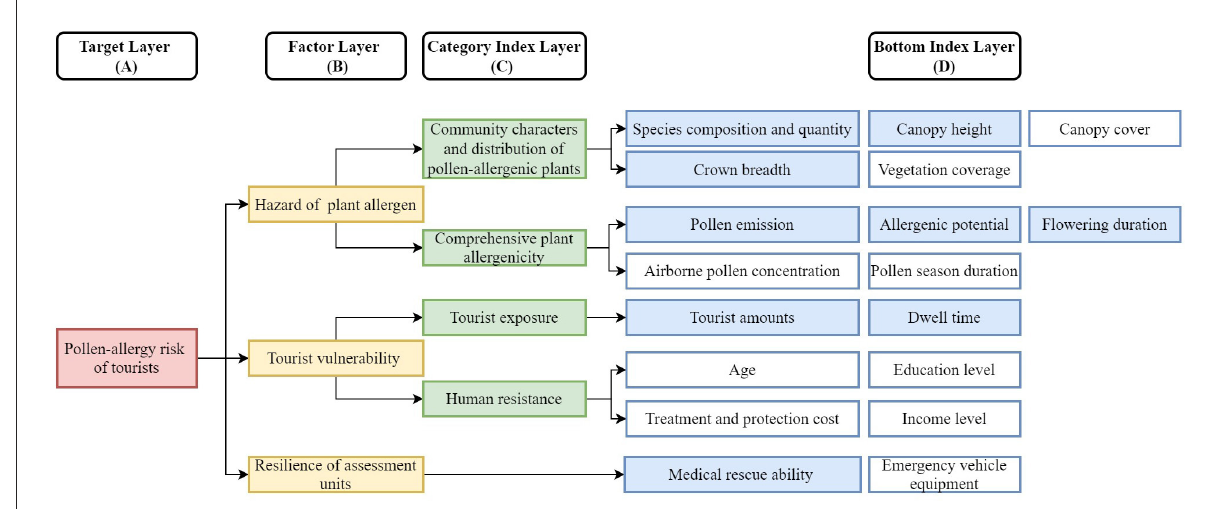
FIGURE1 The construction of index system for tourist pollen-allergy risk in attractions (Blue indexes were used in the case study of the Summer Palace).